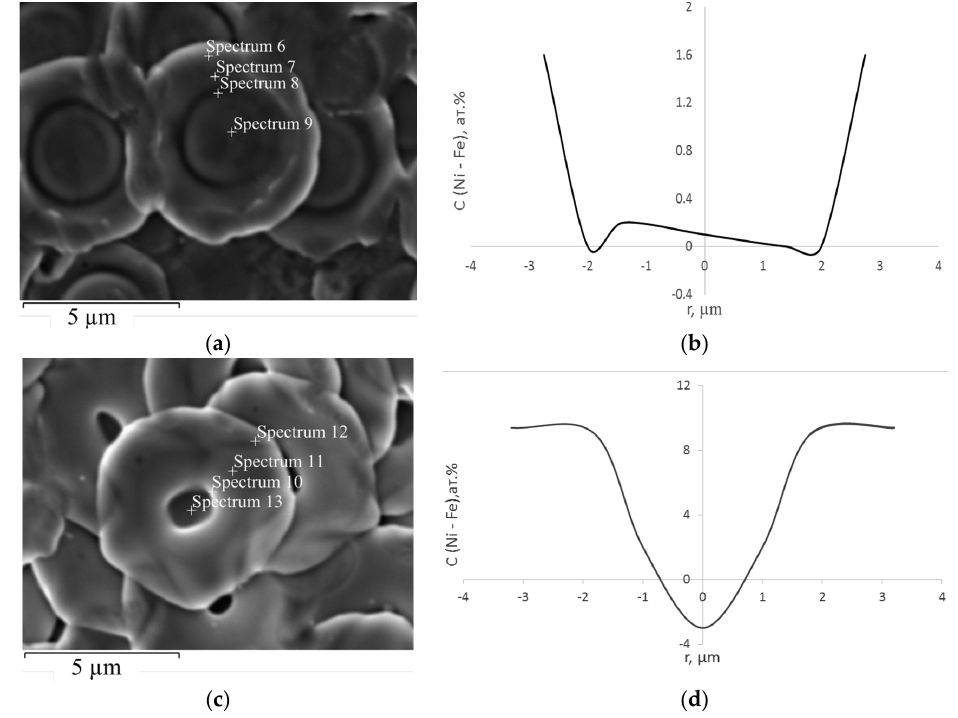
Figure 3. SEM images and energy dispersive X ‐ ray microanalyzer (EDXA) distributions of the radial difference in the concentration of nickel and iron C (Ni ‐ Fe) at % measured for the coatings on the working surface of RS blades after the commutation test with I c = 0.8 A and 10 6 switching cycles: ( a , b ) cathode; ( c , d ) anode. Crosses and inscriptions on the SEM images indicate the position of EDXA measurements. The uncertainty of these measurements was not higher than 0.2 at %.